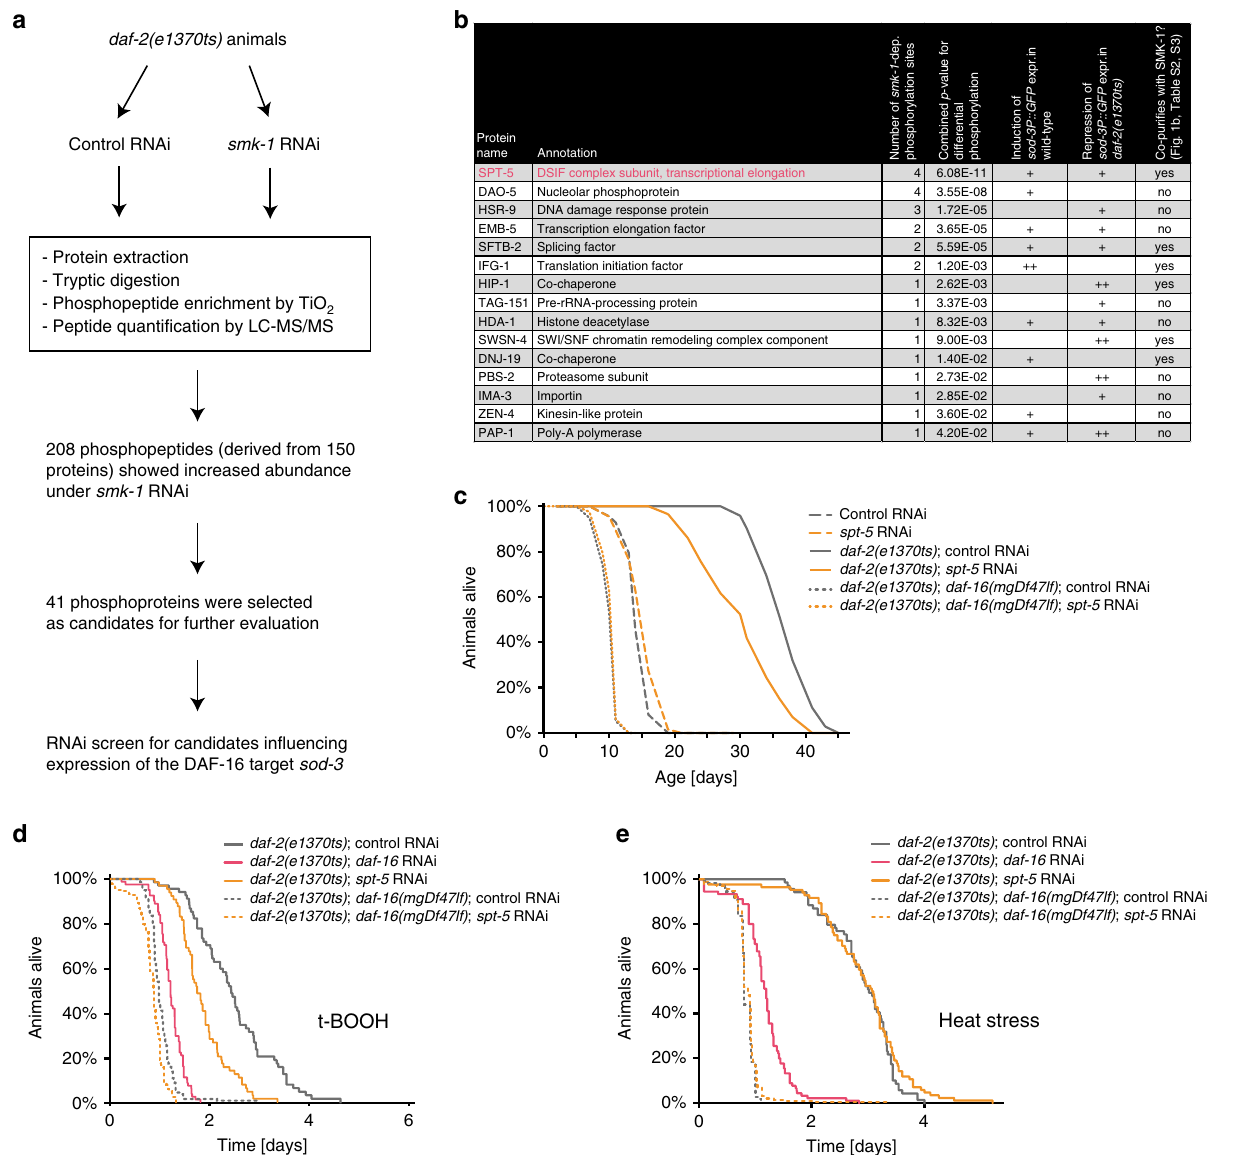
Fig. 6 PP4 SMK-1 promotes DAF-16 ’ s functions under low IIS by dephosphorylating SPT-5. Identi fi cation of the relevant PP4 SMK-1 substrate by unbiased phosphoproteomics and functional evaluation of the emerging candidates. a Work fl ow of the phosphoproteomics approach to identify PP4 SMK-1 substrate candidates, followed by their functional evaluation through RNAi screening using a sod-3P::GFP reporter in either wild type or daf-2(e1370ts) backgrounds. b Results from the approach shown under a . The table is limited to proteins that were found signi fi cantly more phosphorylated upon smk-1 RNAi and that additionally affected expression of sod-3 , i.e., by sod-3 induction in wild type or the repression of sod-3 expression in daf-2(e1370ts) mutant animals. The table is ranked by the signi fi cance ( p value) of the increased phosphorylation observed upon smk-1 RNAi. SPT-5 is highlighted in red as being the top- ranked candidate from this prioritization approach. c – e Loss of SPT-5 phenocopied the stress resistance and lifespan phenotypes caused by loss of SMK-1. All strains used in in this fi gure harbored the eri-1(mg366ts) mutation to yield better knockdown ef fi ciencies 51 . Wild type, daf-2(e1370ts) , or daf-16 (mgDf47lf) ; daf-2(e1370ts) mutant animals were grown from the L4 stage on either control or spt-5 RNAi bacteria at 25°C. Animals remained either untreated ( c ), or were grown until day 2 of adulthood and then transferred to either 6 mM tBOOH containing RNAi plates (oxidative stress) ( d ) or shifted to 32 °C (heat stress) ( e ). Survival of the animals was monitored. For detailed statistics see Supplementary Table 4. Source data underlying Fig. 6c – e are provided as a Source Data fi their annotation and the signi fi cance of their smk-1 -dependent differential phosphorylation. To determine the functional rele- vance of these candidate proteins, we used a transcriptional reporter for the canonical DAF-16 target gene sod-3 . This reporter is induced by DAF-16 under low IIS — an induction that requires SMK-1 8 . Hence we knocked down each of the 41 candidates by RNAi in wild type or daf-2 mutant animals carrying Psod-3::GFP and evaluated their GFP expression from